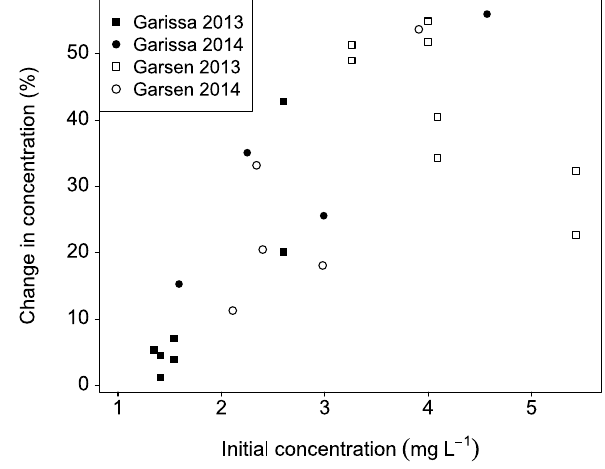
Figure 4. Relative change (in %) between the initial concentration (day 0) and final concentration (day 8) in function of the initial con- centration of the DOC. All available data are